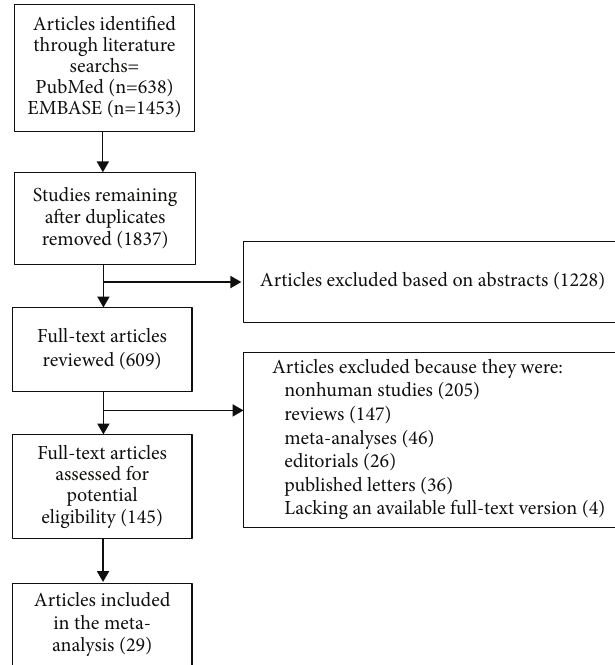
Figure 1: Flow diagram summarizing study identification and